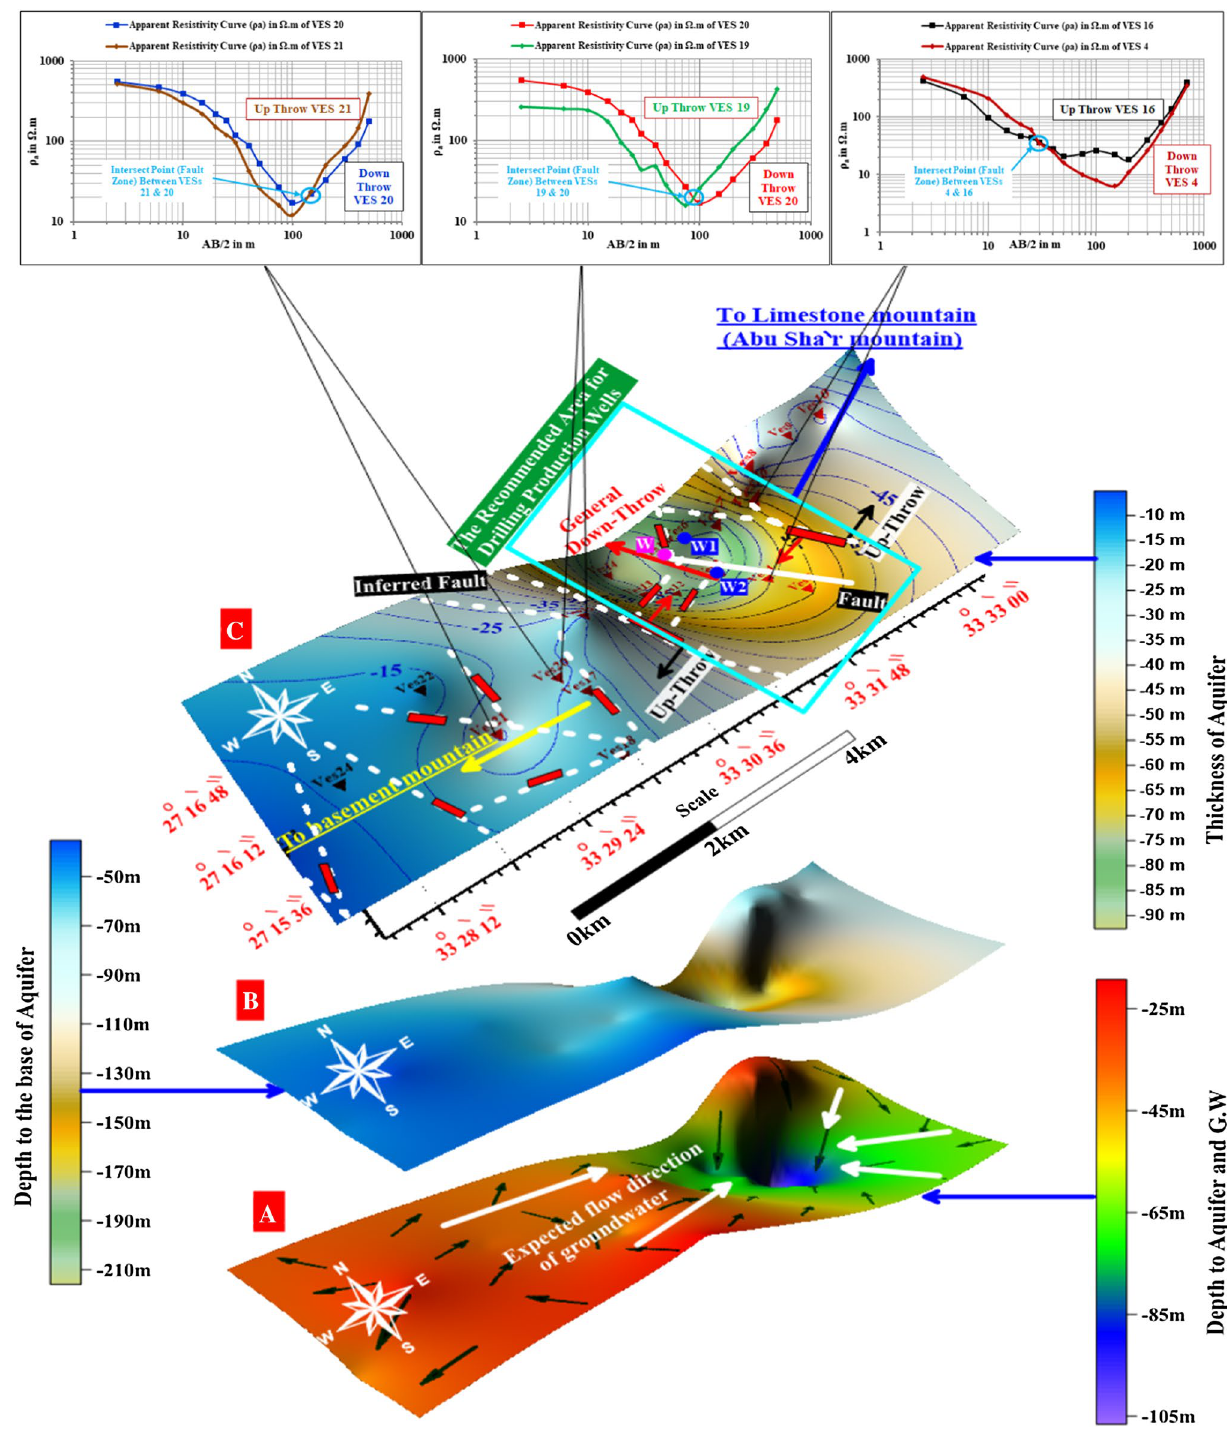
Fig. 7 3-D distribution maps of the depth to the aquifer and ground- water with the expected flow direction of groundwater ( a ), of the depth to the base of the aquifer ( b ), and the thickness of aquifer and the estimated inferred major faults ( c ) with example for delineat- ing the expected fault zones at shallow and deep depths between the different VESCs using the apparent resistivity values according to